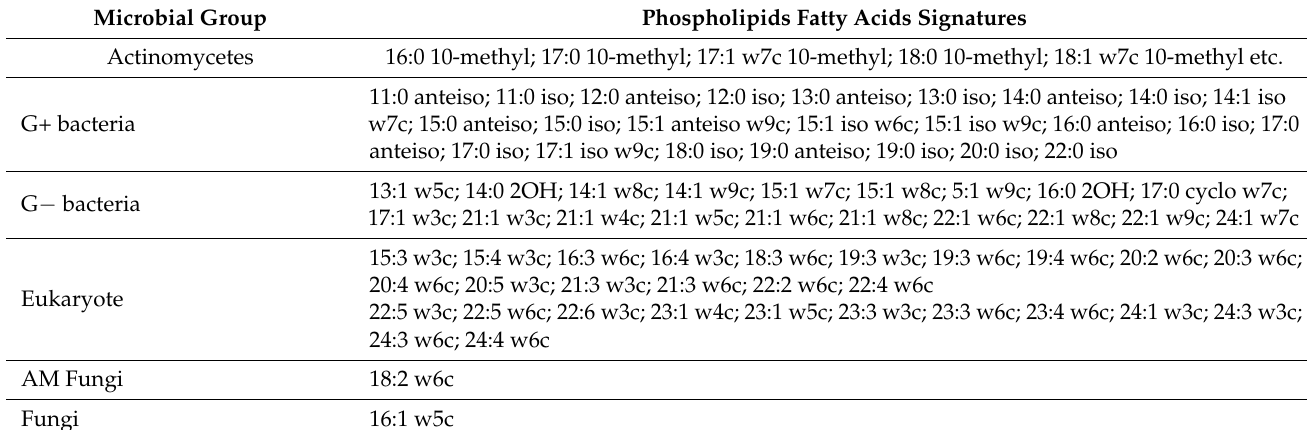
Table 2. Phospholipid fatty acid (PLFA) profiling of soil microbial communities. Microbial Group Phospholipids Fatty Acids